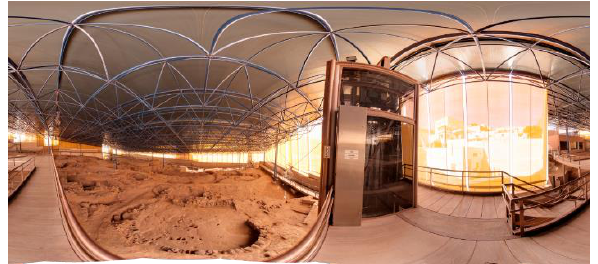
Figure 5. Example of a panorama obtained